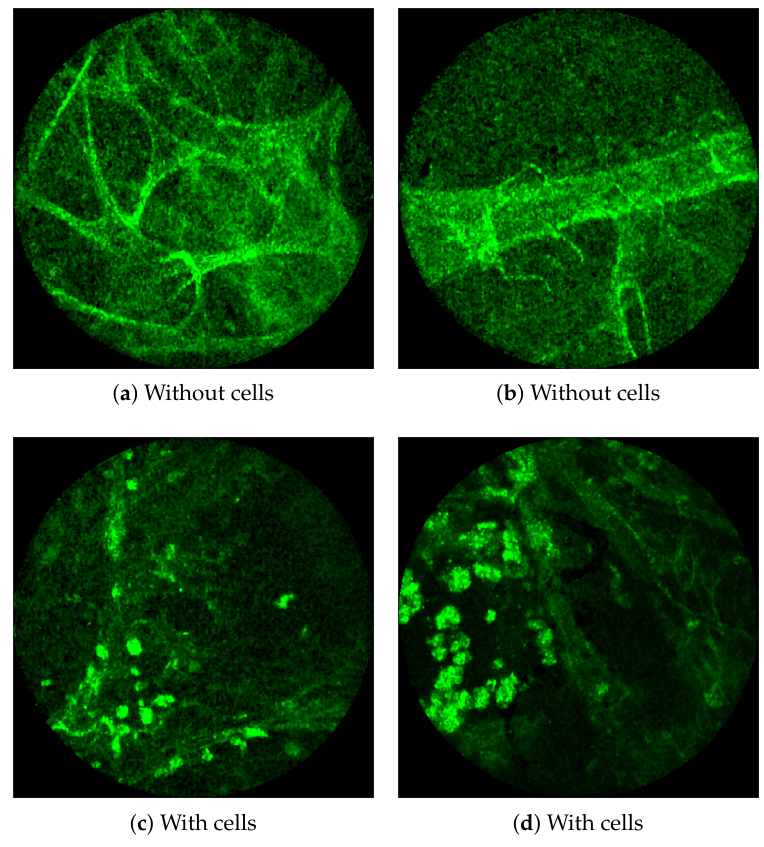
Figure 1. FCFM image frames with or without cells. The images are of 600 by 600